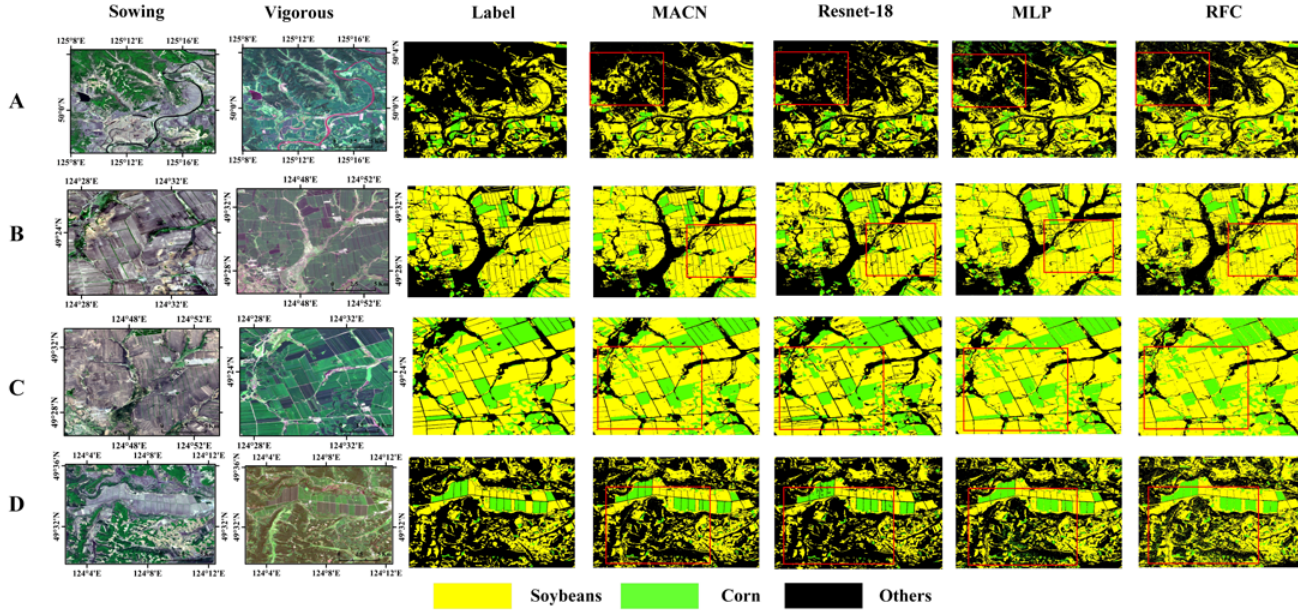
Figure 9. The recognition results for the different models in the four test areas.